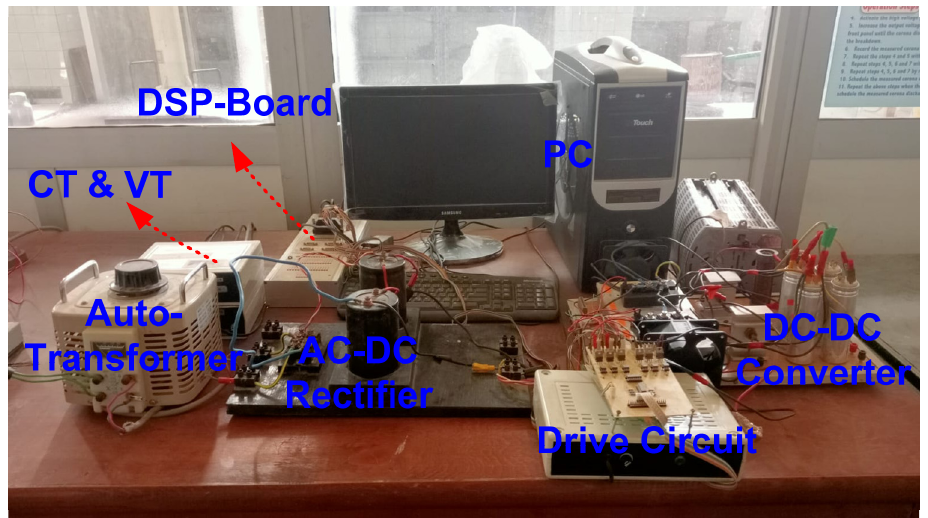
Figure 34. Photograph of the experimental setup.